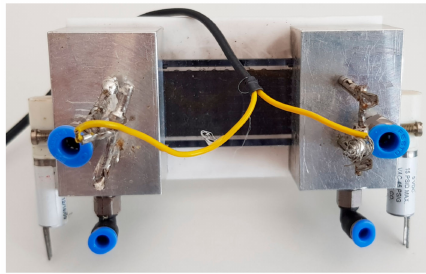
Figure 1. Silicon fabricated preconcentrator enclosed in housing